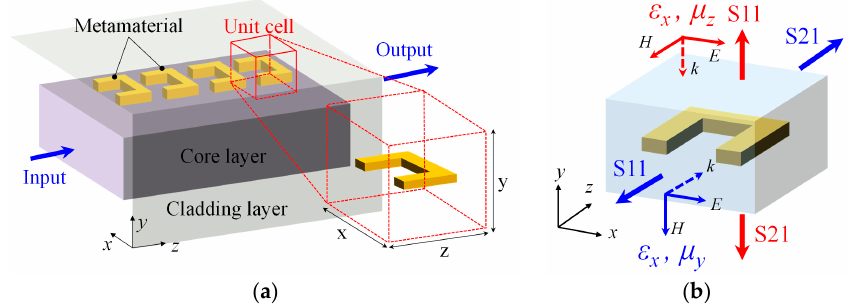
Figure 2. ( a ) Optical waveguide with a split-ring metamaterial on its surface. A uniform layer is substituted for the metamaterial and its neighborhood; ( b ) Retrieval of permittivity and permeability values from S parameter.